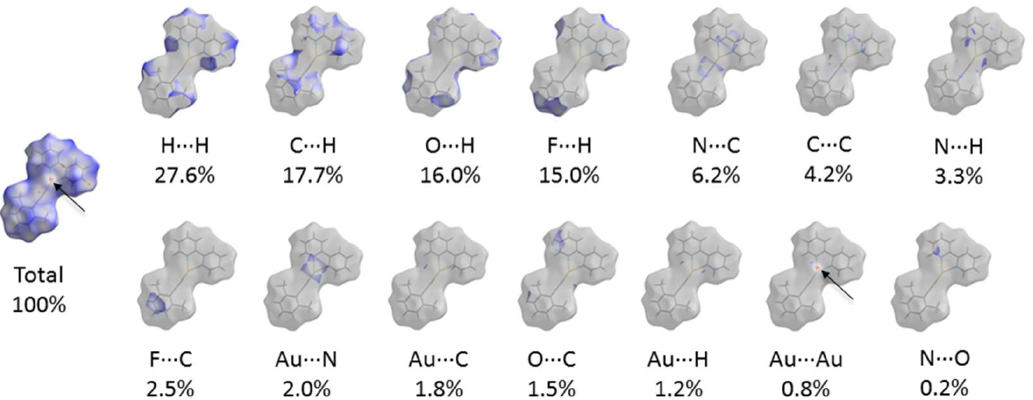
Figure 4. Visualization of Hirshfeld surface analysis for the X-ray structure of 4 . Area responsible for intermolecular contacts Au···Au (aurophilic interactions) indicated by black arrows.